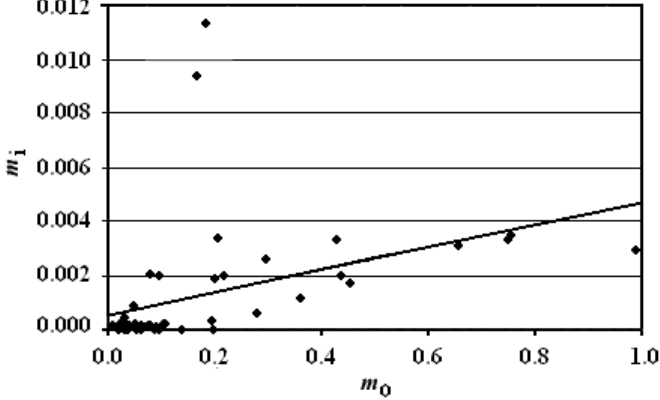
FIGURE 5. Direct significant correlation (linear regression, r = 0.390813535, t = 2.81634826, p < 0.01) between m 0 and m i . Data are from